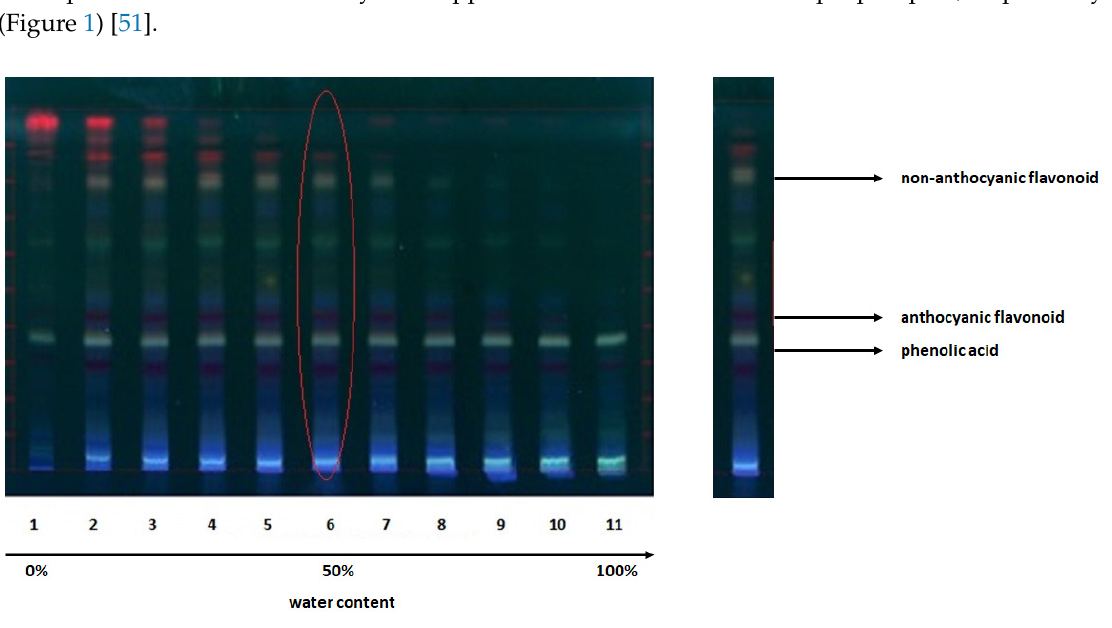
Figure 1. Typical image of high-performance thin-layer chromatography (HPTLC) separations for diagnostic fingerprint of sample extracts, after NP/PEG 400 derivatization.